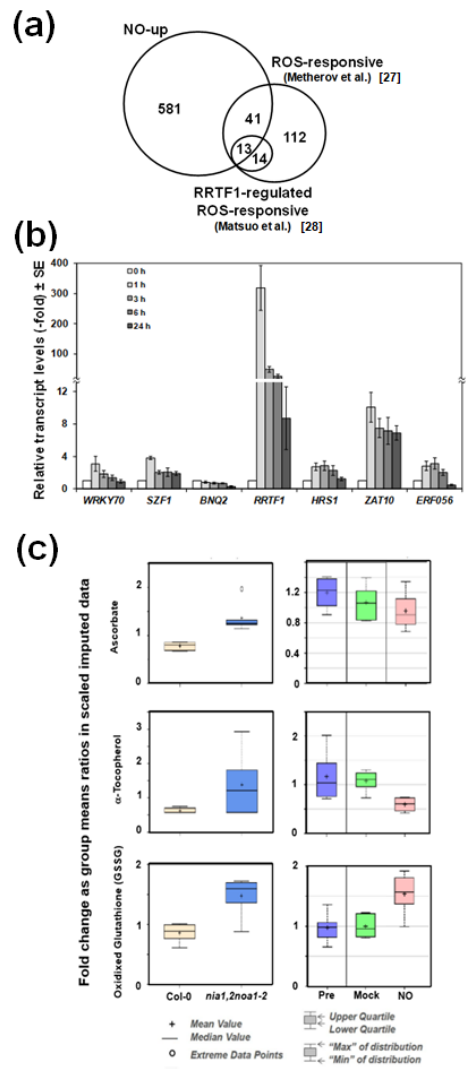
Figure 3. Effect of NO on the redox status of the plants. ( a ) Venn diagram showing the overlaps between NO up-regulated, ROS-responsive, and RRTF1-regulated genes. ( b ) Levels of ROS-related transcription factor encoding genes were analyzed by qRT-PCR with RNAs isolated, at the indicated times, from NO-exposed Col-0 plants. Values are the mean ± standard error of three independent biological replicates. ( c ) The levels of antioxidants were analyzed by LC-MS in Col-0 and the NO-deficient nia1,2noa1-2 mutant plants (left boxes) and wild type Col-0 plants (right boxes) before (Pre) and after 6 h exposure to 300 ppm NO (NO) or control untreated (Mock). Values are the mean of six independent biological replicates. The boxes represent the mean and median values with the upper and lower quartile limits as well as the maximum and minimum of the distribution and extreme data points.